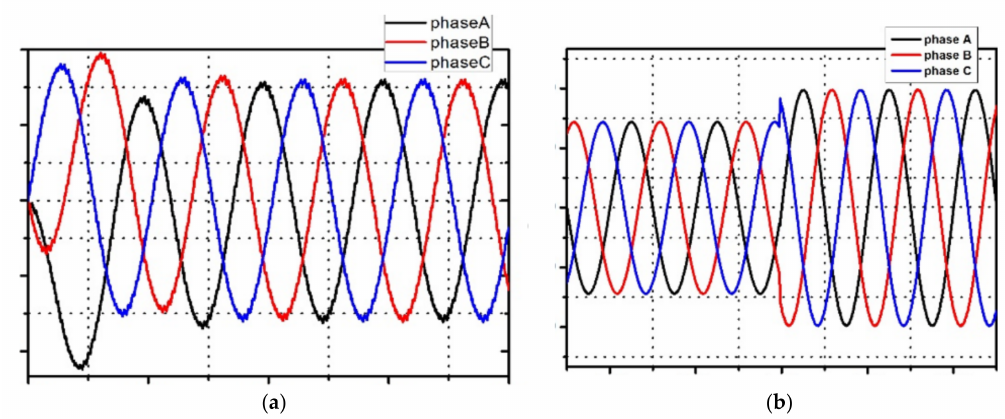
Figure 4. Transient output current: ( a ) transient grid side current at start time; ( b ) dynamic response of grid-connected current.